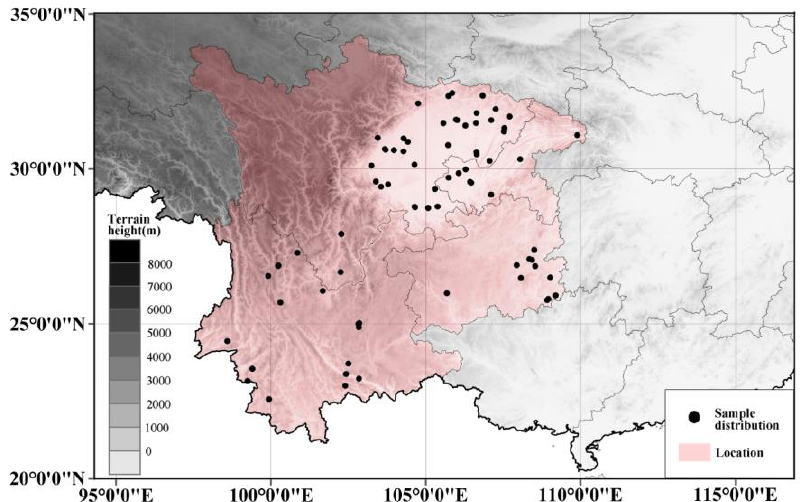
Figure 3. Sample distribution in China. The distribution of the sample is concentrated in areas of intense human activity, while the northwestern part is a highland terrain, where no local buildings were selected in view of the high environmental impact and the small number of buildings.